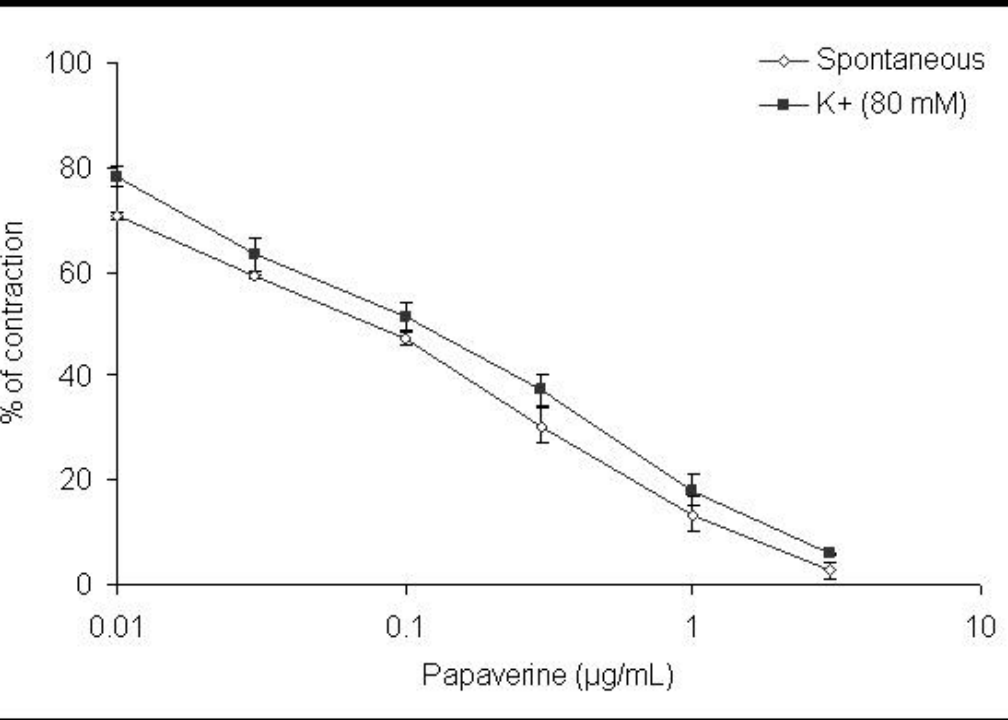
N = 6; Data are expressed as the mean ±